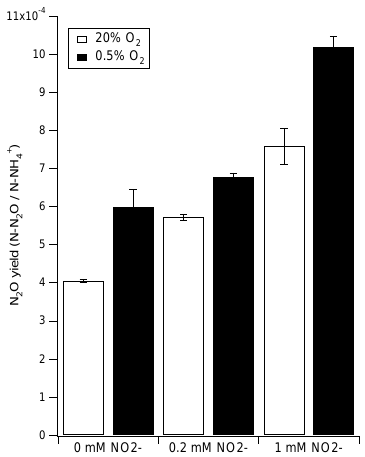
Fig. 3b. N 2 O yields increased when NO − was added to the starting 2 media. Initial NH + concentrations were 50µM. Added NO − was Fig. 3a. N 2 O yields increased when NO − 2 was added to the starting media. Initial NH + 4 concentrations were 4 2 50 µ M.Added NO − 2 waseither0,0.2mM,or1mM. either 0, 0.2mM, or 1mM.